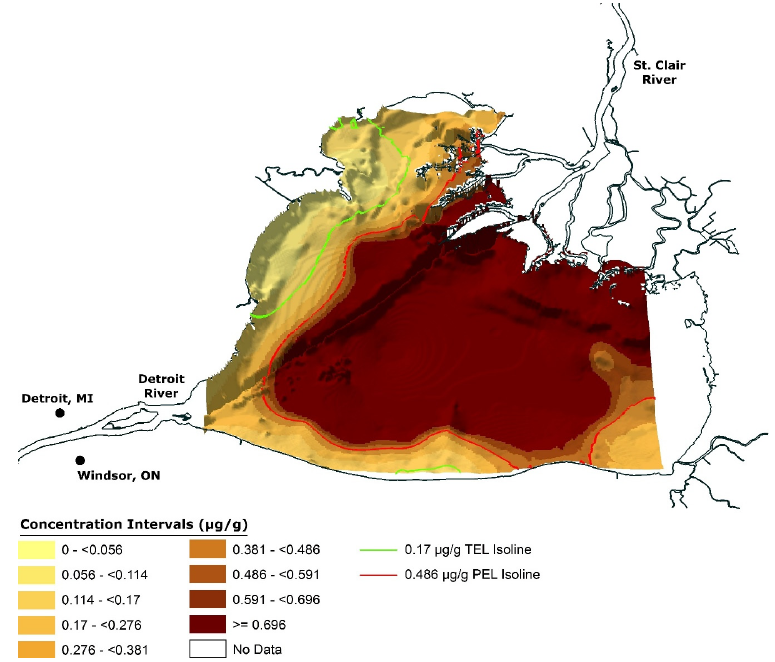
Figure 5. Three ‐ dimensional interpolated kriging distribution map for 1974.